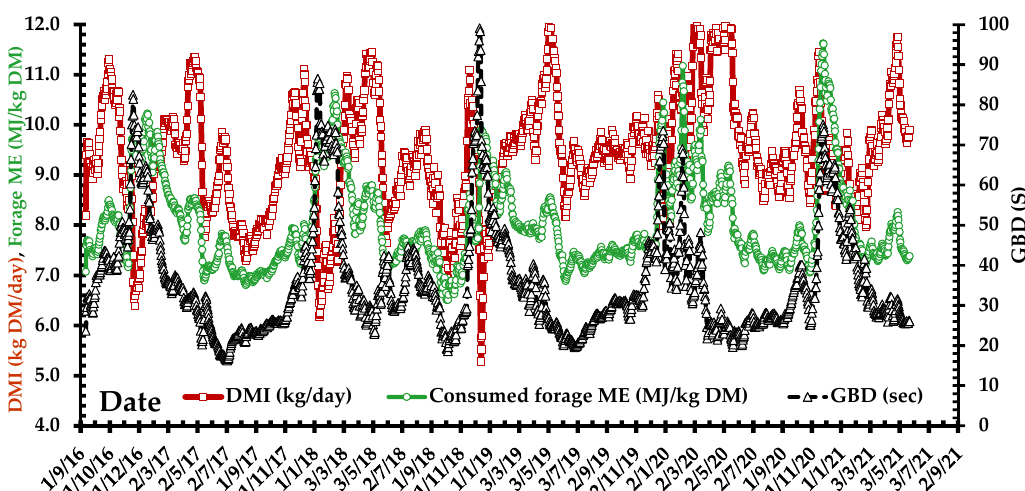
Figure 7. Studied cows’ actual consumed dietary ME (MJ/kg DM, o), dry matter intake (DMI, kg DM/day, □ ), and daily grazing bout duration (GBD, s, ∆ ) used to estimate forage availability. Dates are given as day/month/year.